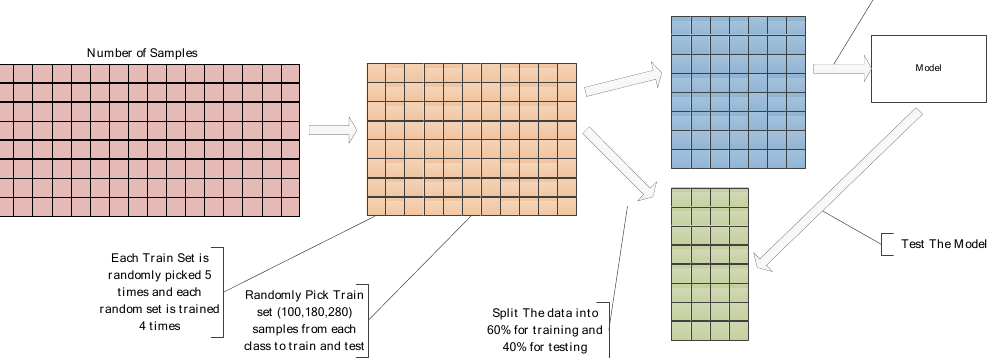
Figure 9. Performance evaluation based on various numbers of training samples.